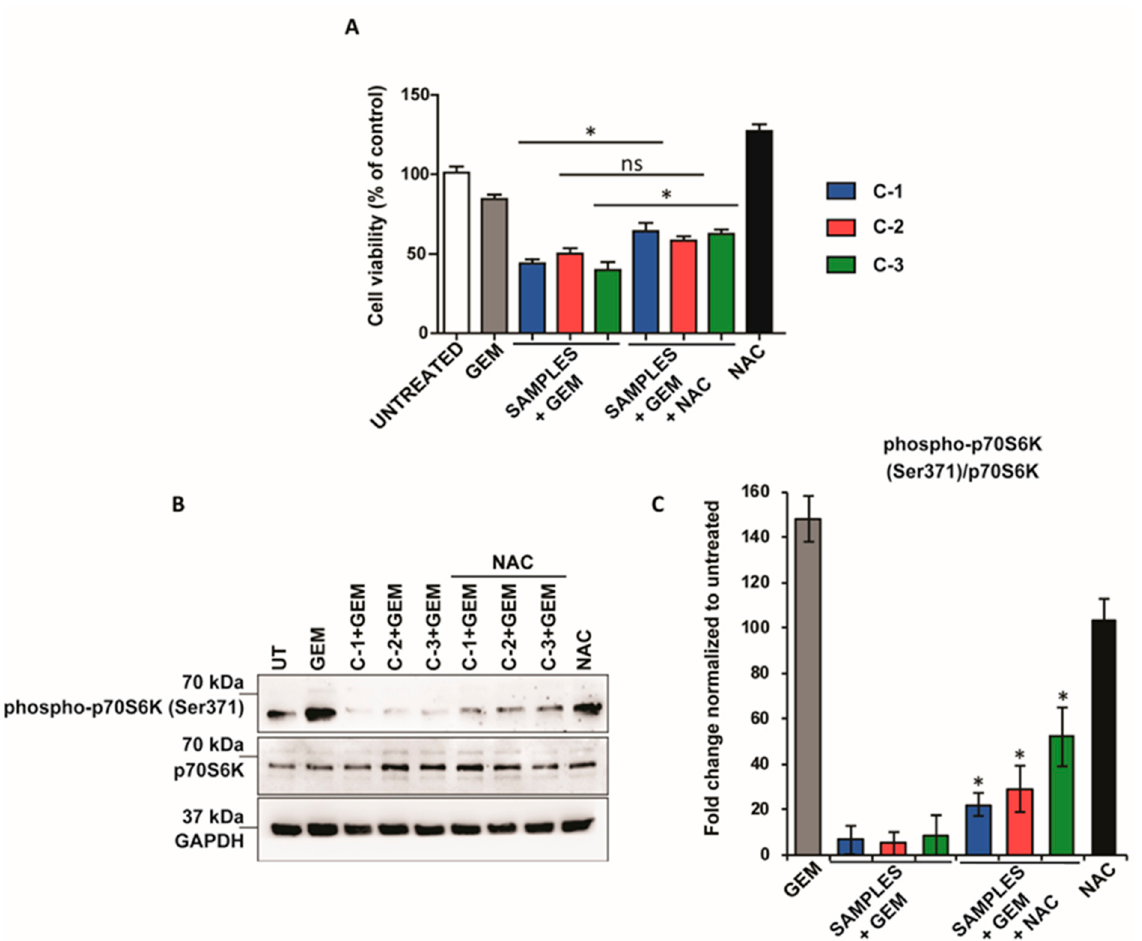
Figure 5. Combined treatment attenuates the mTOR pathway in an ROS-dependent manner. ( A ) PANC-1 cancer cell lines treated with 4.5 µ M GEM, 500 µ M NAC, and 1 mM C-1 (blue), C-2 (red), and C-3 (green) for 48 h. Their viability was assessed with the alamarBlue test. The values of treated cells were normalized to that of untreated controls and reported as mean ± SEM. ( B ) Western blot analysis of phospho-p70SK6 and p70S6K of PANC-1 cells after treatment with 4.5 µ M GEM, 500 µ M NAC, and 1 mM of C-1 , C-2 , and C-3 for 48 h. GAPDH protein level in the same extract was used as a control loading. ( C ) Densitometry of bands was performed using NIH Image J software and reported as fold change with respect to the untreated condition. The values reported are the mean of three experiments and were reported as mean ± SEM). Statistical analysis was performed using one-way ANOVA (C-1+GEM, C-2+GEM, C-3+GEM vs C-1+GEM+NAC, C-2+GEM+NAC, C-3+GEM+NAC)., * p <